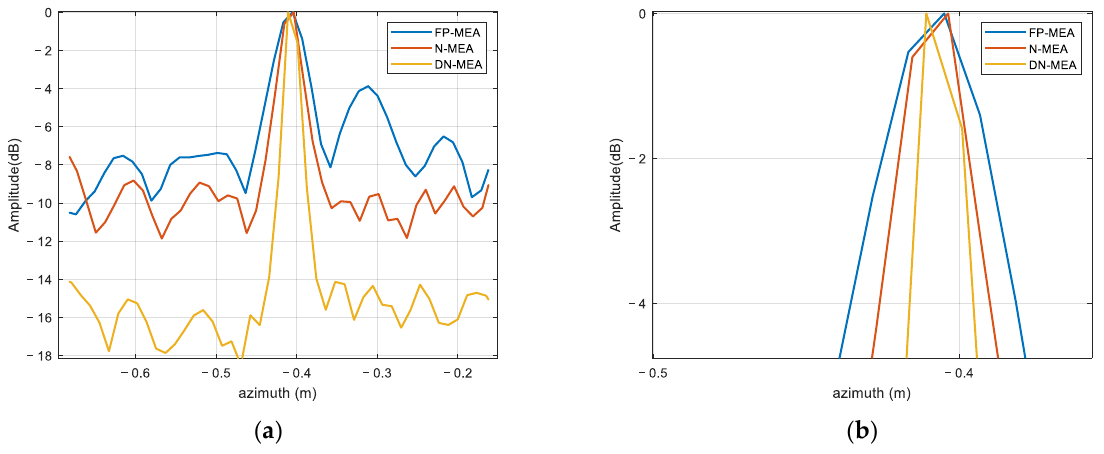
Figure 11. Azimuth profiles of the target imaging result: ( a ) original results; ( b ) local amplification .